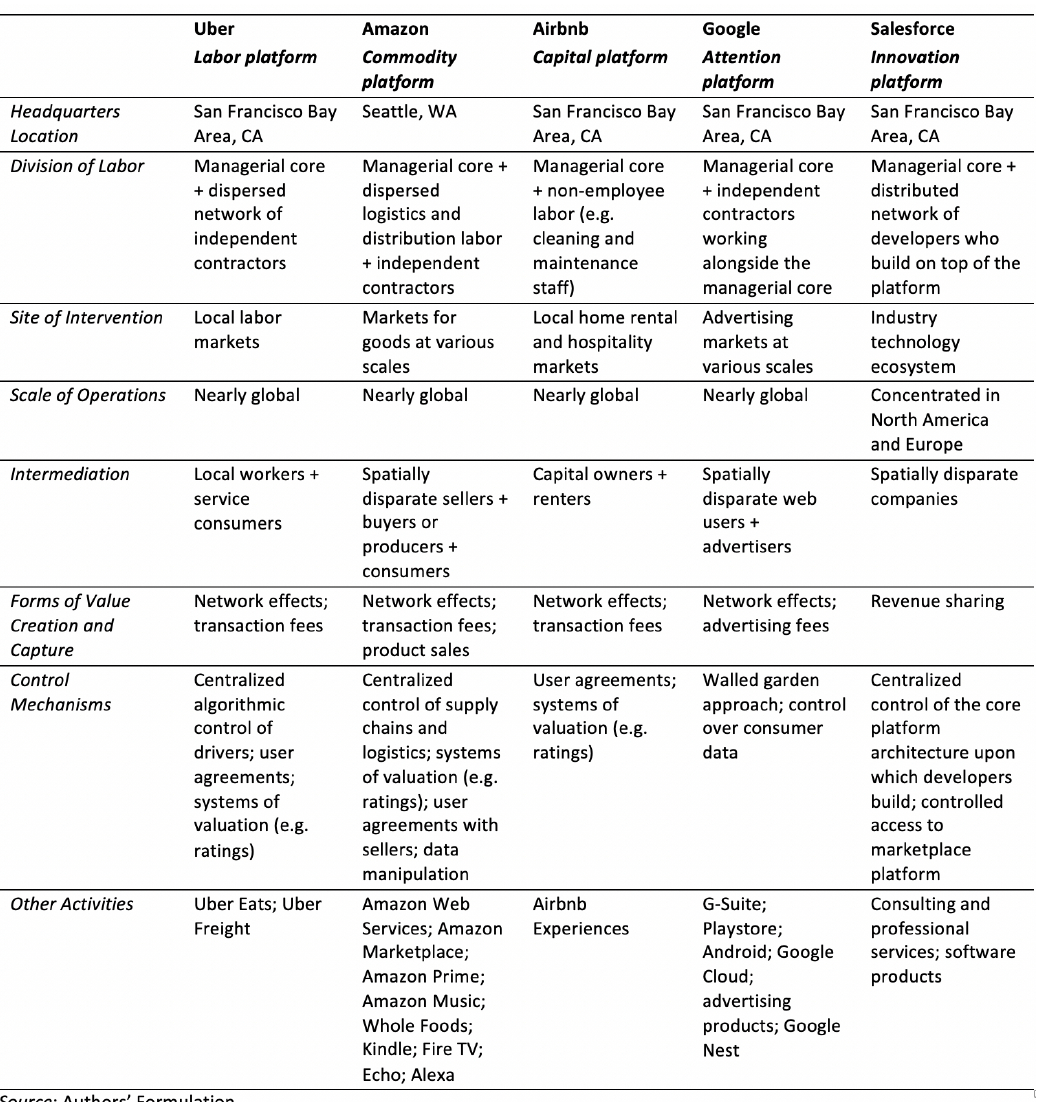
Table 2: Spaces of Platform Capitalism II: Corporate